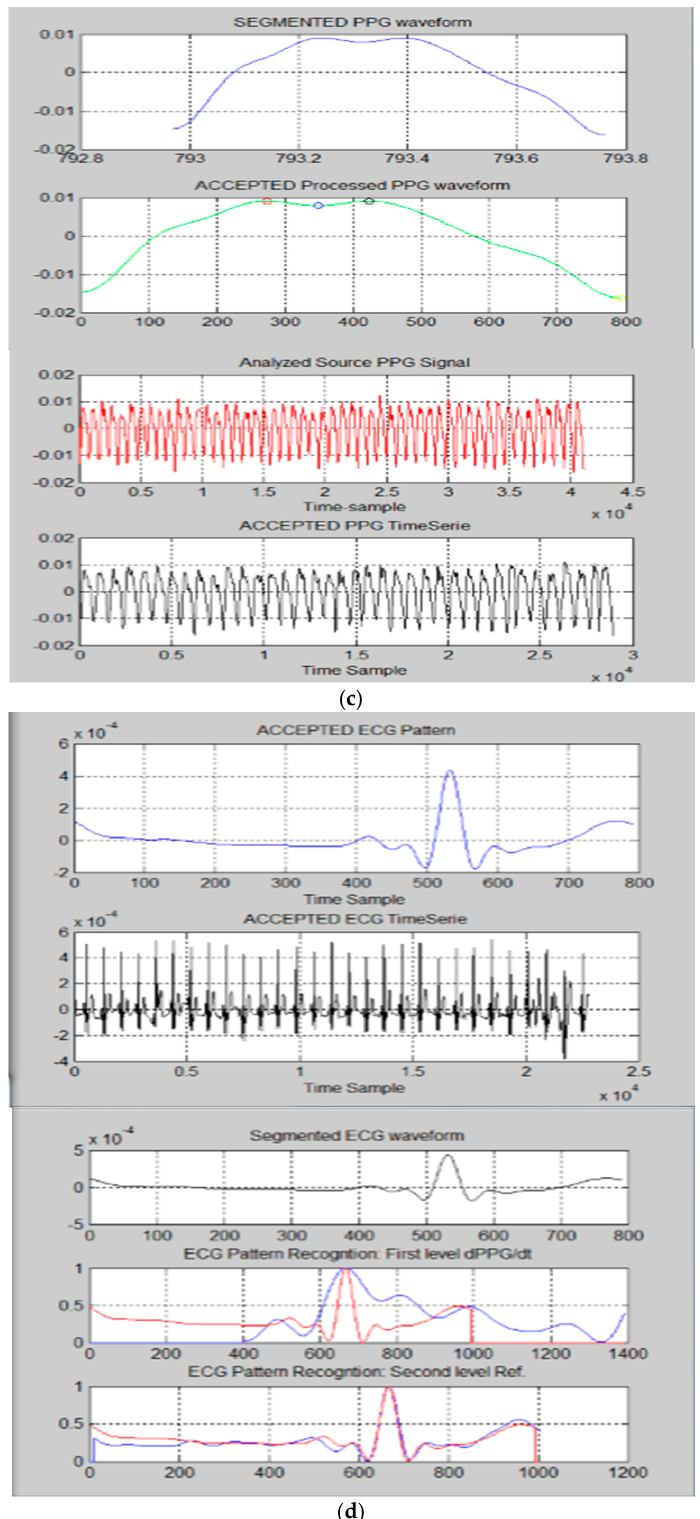
Figure 20. ( a ) The first sub-window shows an instance of noised PPG signal (red) properly filtered as reported in the second sub-window; ( b ) Medical indicators computation (HRV, Augmentation index (AI), BPM) included in the Pattern Recognition System GUI; ( c ) The described PPG pattern recognition system with detail about accepted PPG waveforms; ( d ) The proposed ECG pattern recognition diagrams with detail about accepted ECG